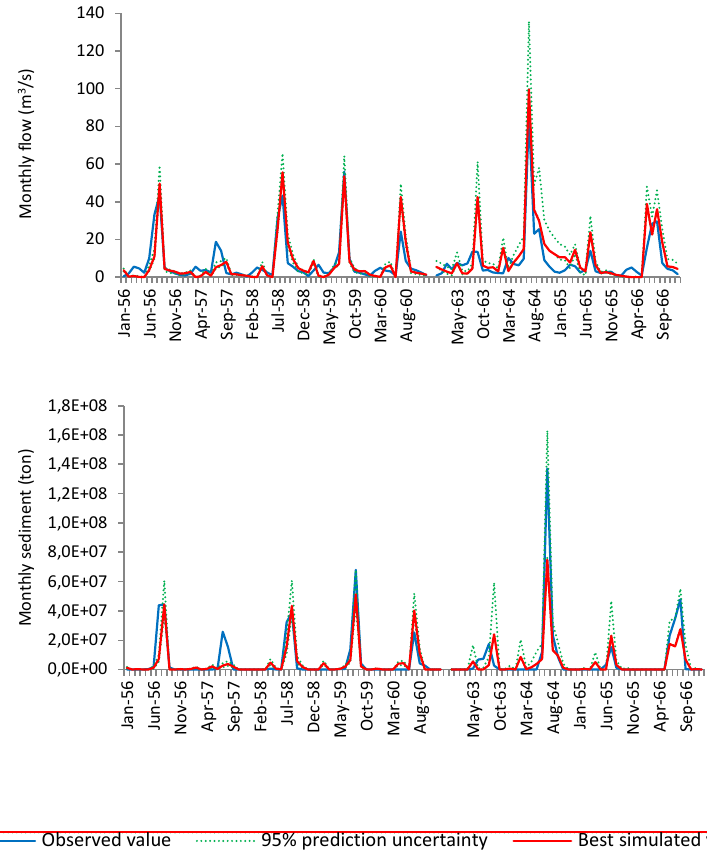
Fig. 3. Simulation results in the reference period